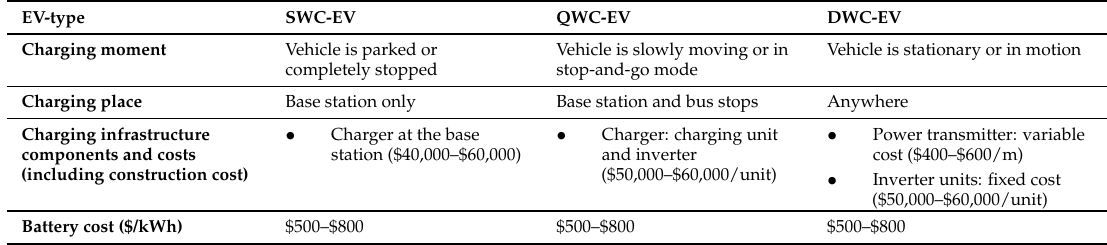
Table 1. Characteristics of each EV type (based on the current OLEV system